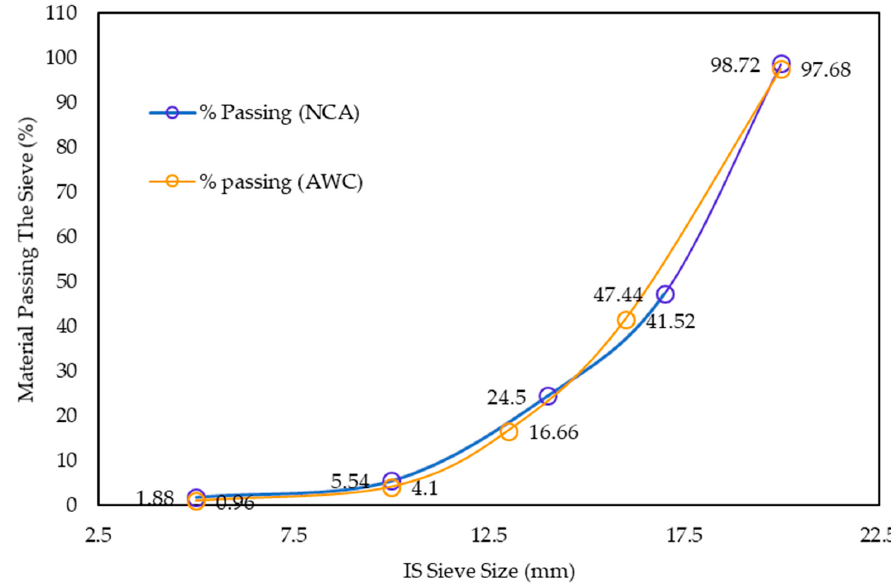
Figure 1. Particle size distribution of natural coarse aggregate and ceramic coarse aggregate.